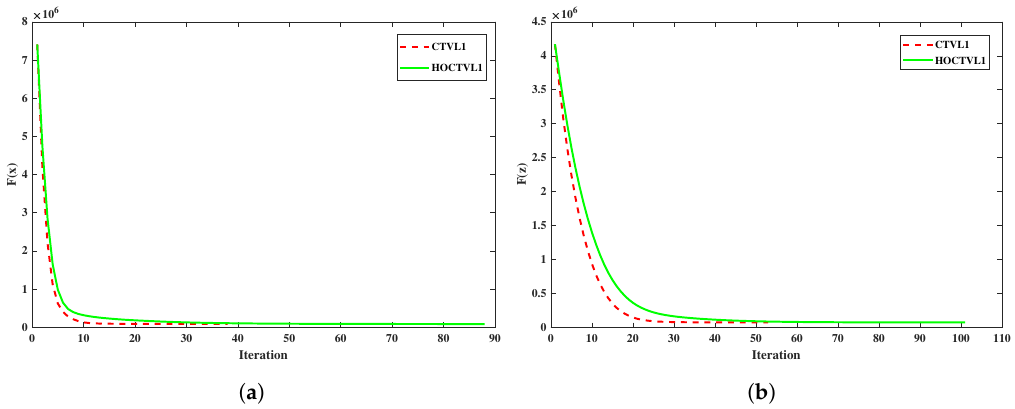
Figure 16. Change of F ( z ) value with Iteration number. ( a ) Corruption: 30%; ( b ) Corruption: 50%.